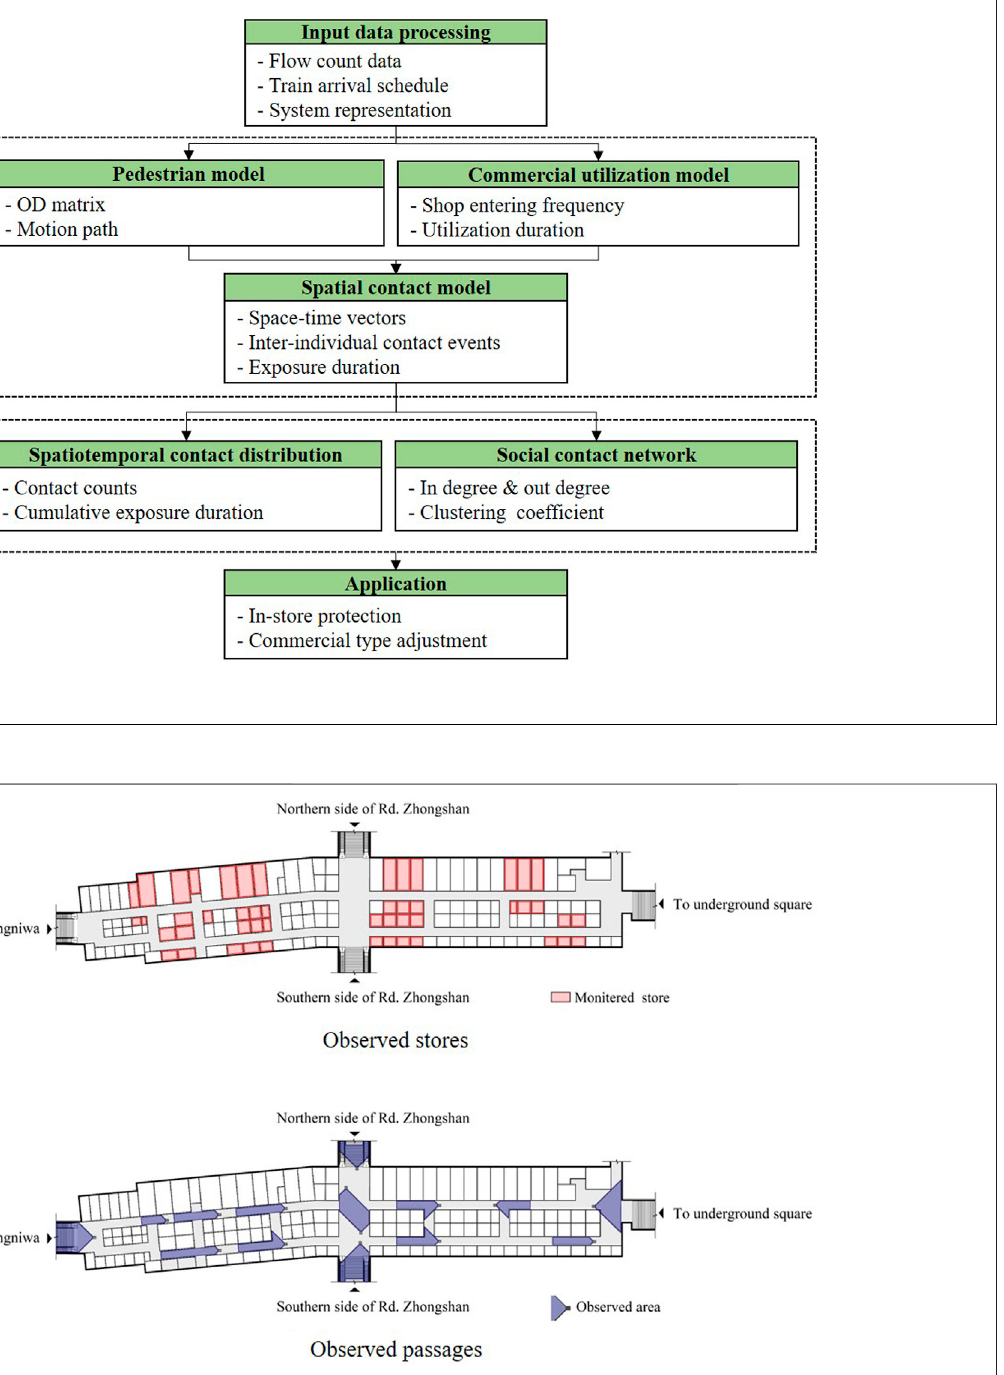
Frontiers in Physics |